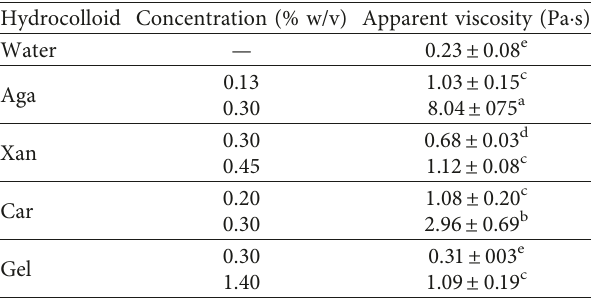
Table 1: Concentration and corresponding apparent viscosity of each hydrocolloid solution before injected to meat